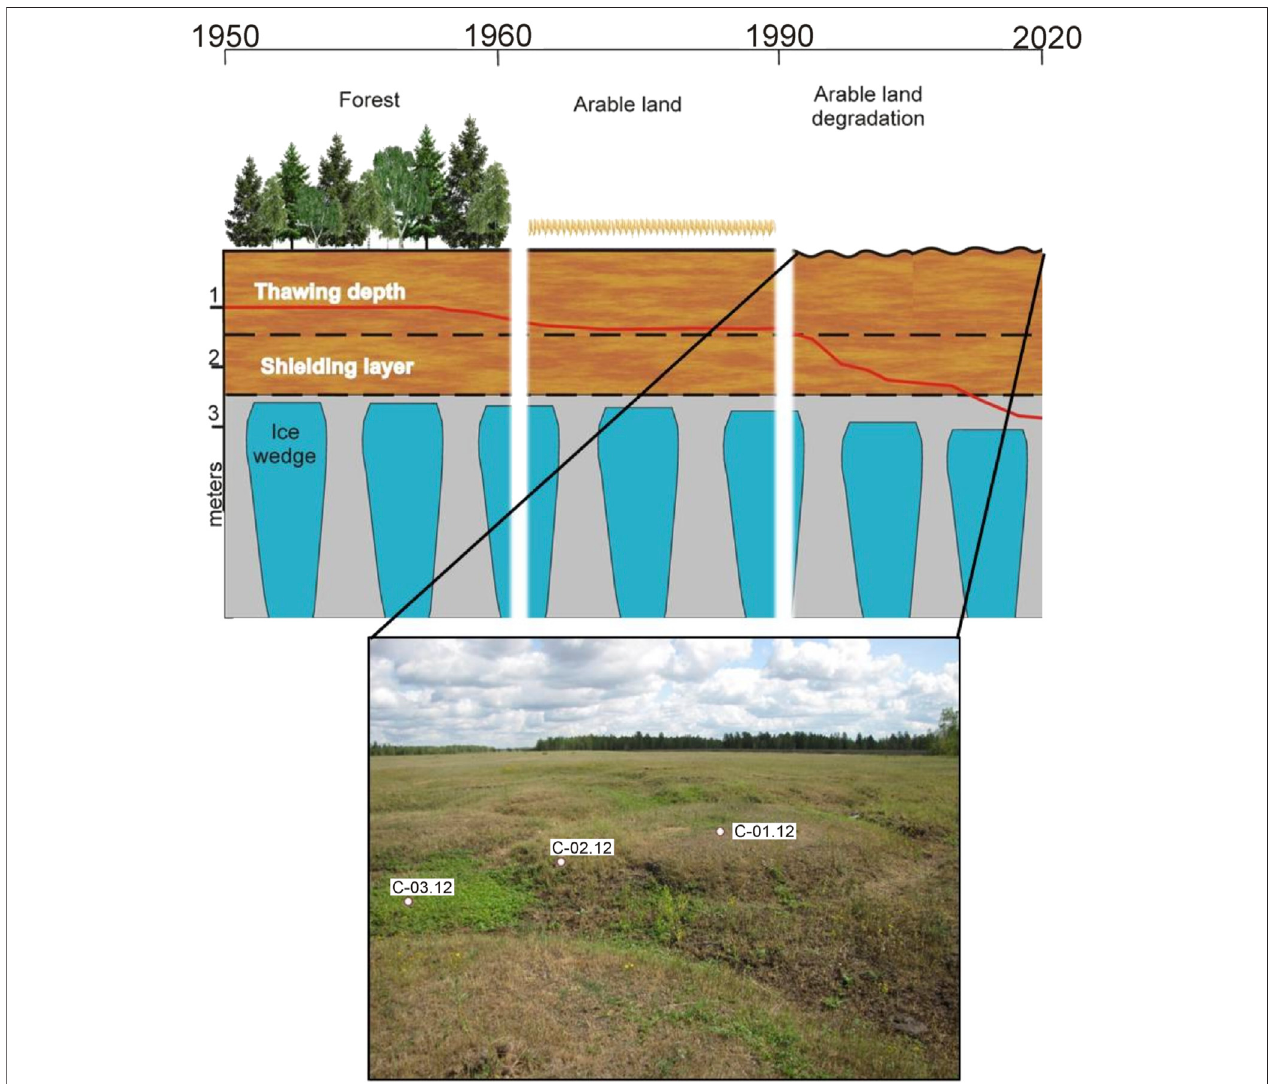
FIGURE 4 | Development scheme, general view, and location of studied soil pits on the former arable fi eld (Churapcha site) abandoned in the early 1990s and subjected to thermokarst with the formation of byllar microtopography.